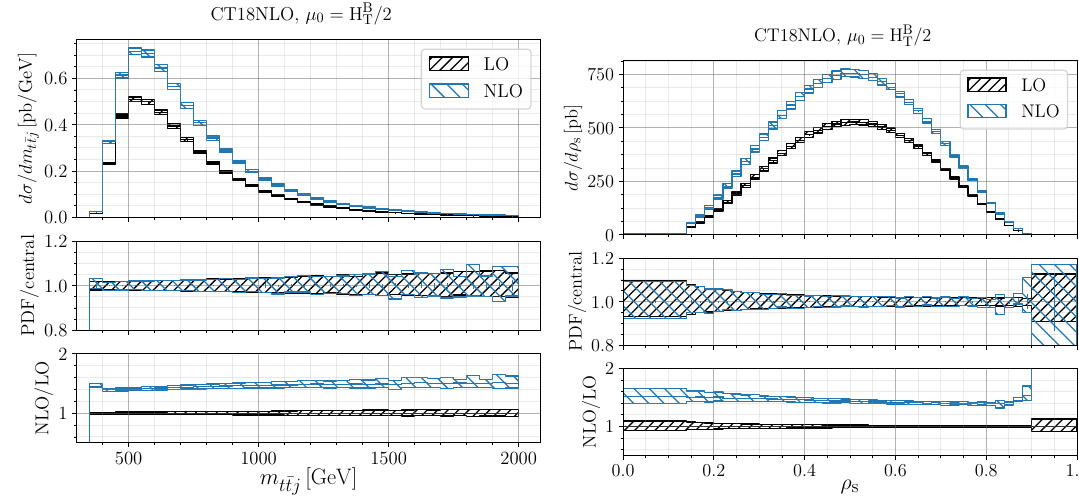
Figure 19 . Same as figure 17, but for the m